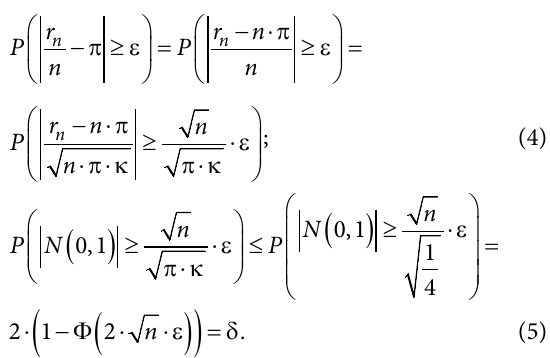
Figure 3. 100 needle lift and pressure traces for 1400 min –1 , 400 N ⋅ m, 0°, 0.1 MPa measurement point